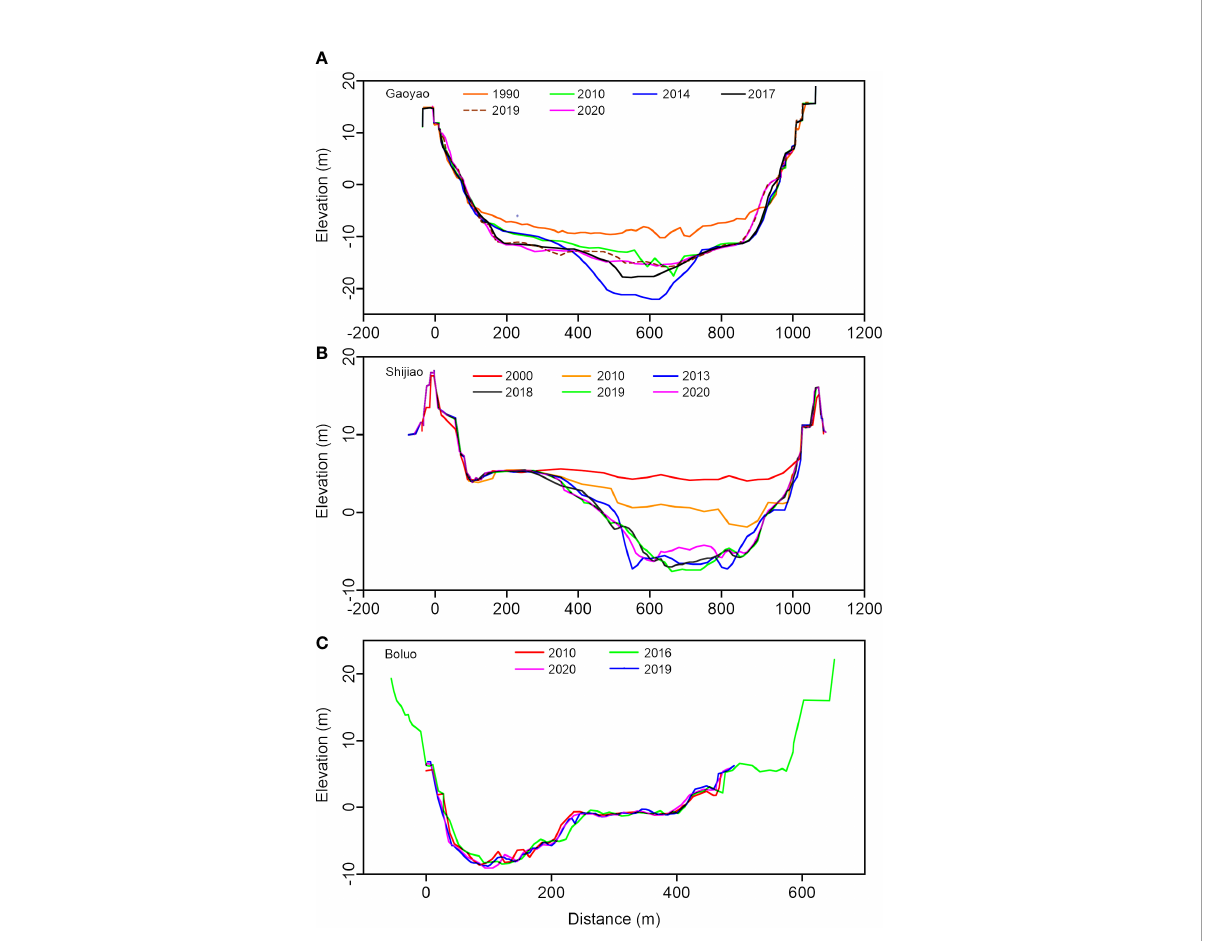
FIGURE 9 Temporal changes in bottom elevation of cross-sectional pro fi les in the Gaoyao (A) , Shijiao (B) , and Boluo (C)